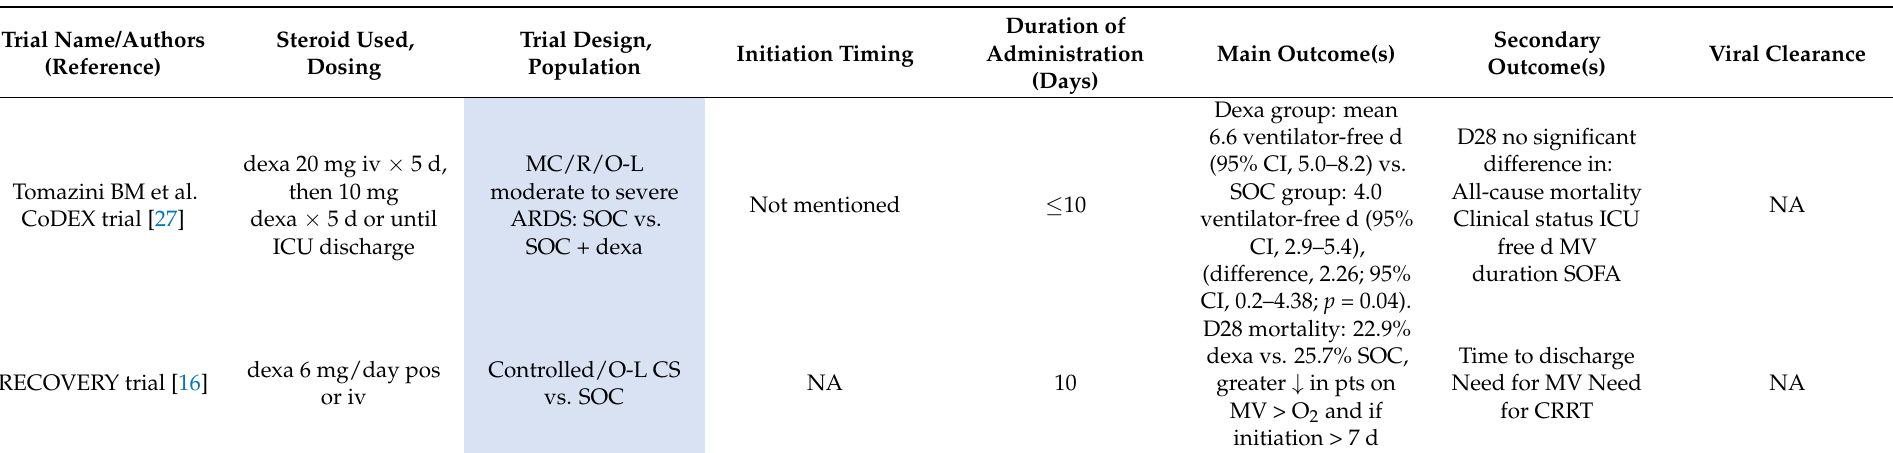
Table 2. Trials using dexamethasone (dexa); design (R = randomized in blue and Rs = retrospective and obs = observational in yellow), timing, duration, outcomes (focusing on mortality data), and viral shedding.